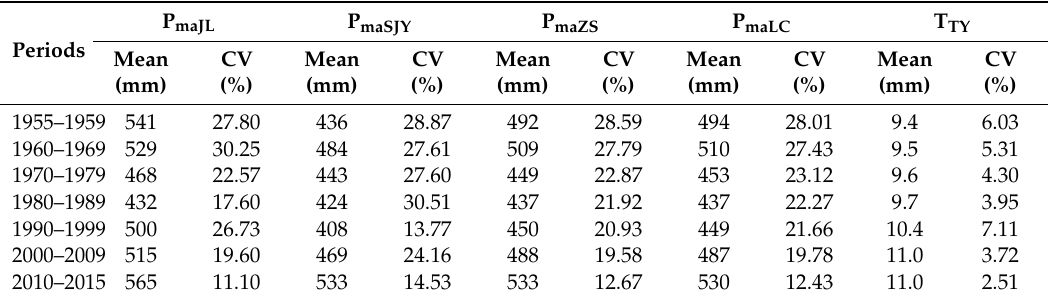
Table 1. Variations of the average annual precipitation at four catchments and the annual average air temperature at Taiyuan meteorological station for the different periods. P maJL Periods